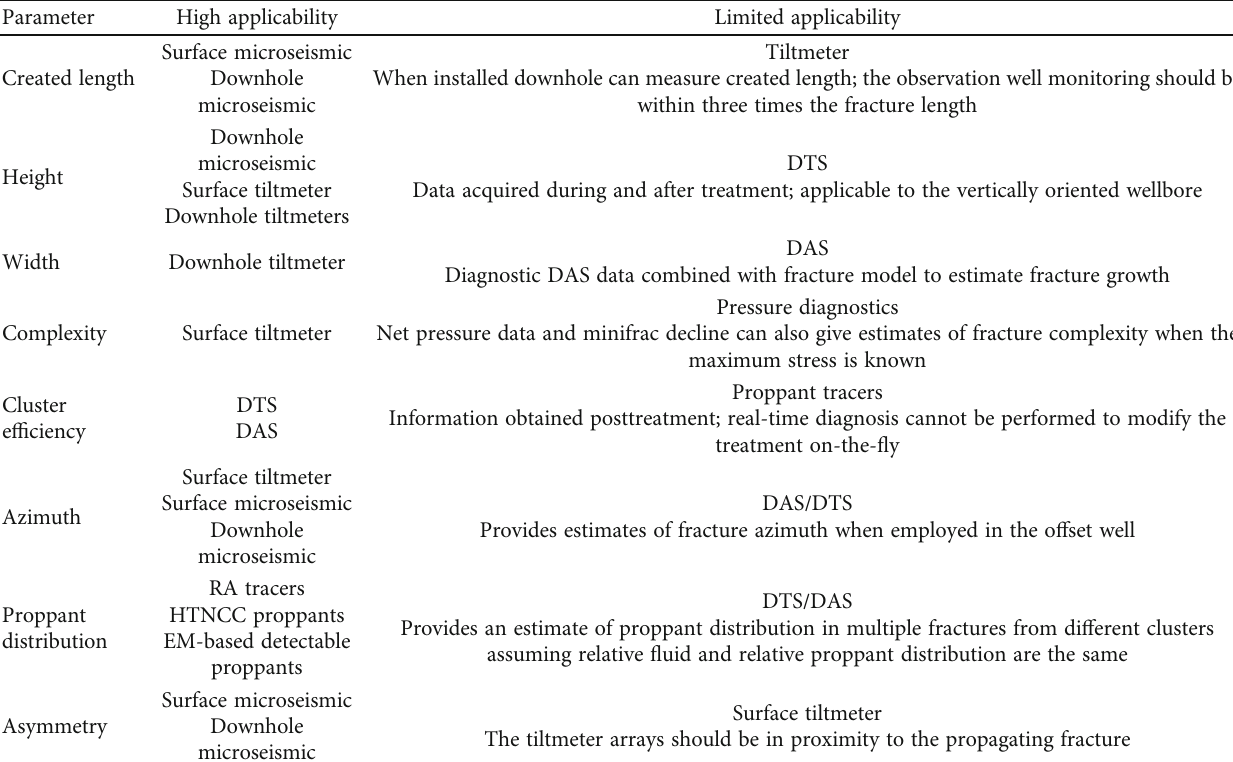
Table 2: Application of fracture diagnostics for characterizing fracture